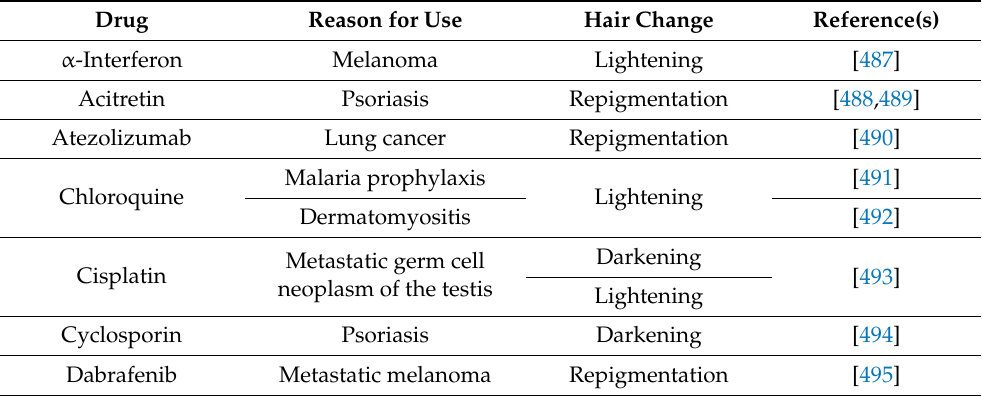
Table 2. Drugs reported to change the colour of hair as a side effect of medical treatments. Drug Reason for Use Hair Change Reference(s) α -Interferon